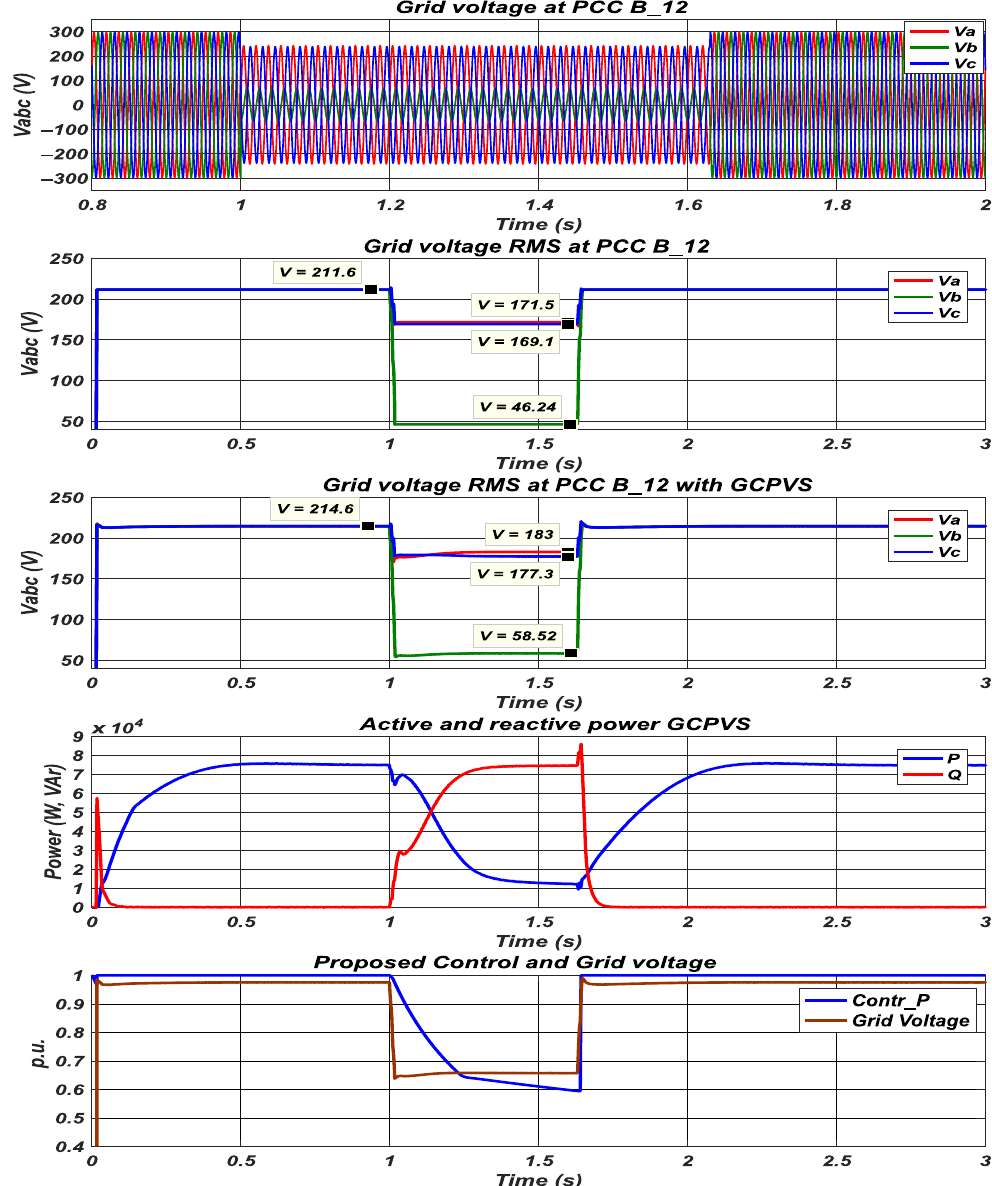
Figure 15. Simulation results of the GCPVS proposed for SDVV/MVD: phase-to-phase-to-ground short-circuit for 625 ms.